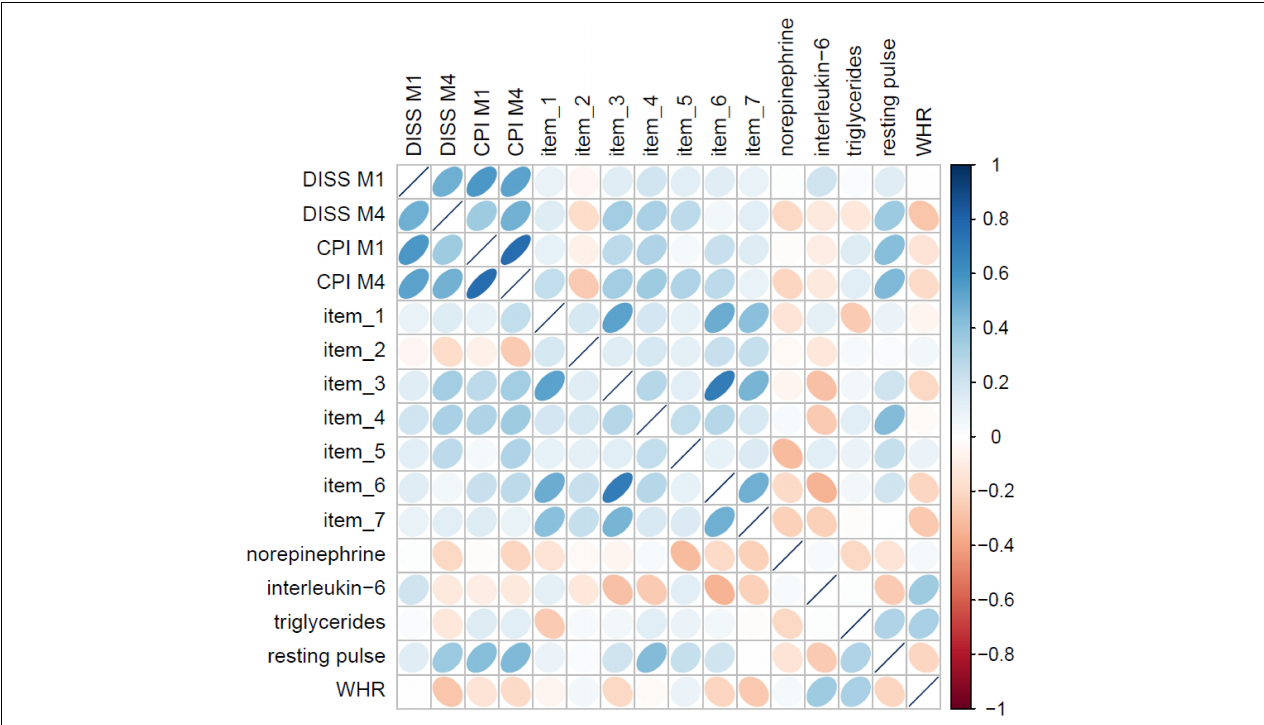
FIGURE 4 | Correlation matrix of the seven psychometric items and five biometric markers from the LASSO models with pain M1 and M4.